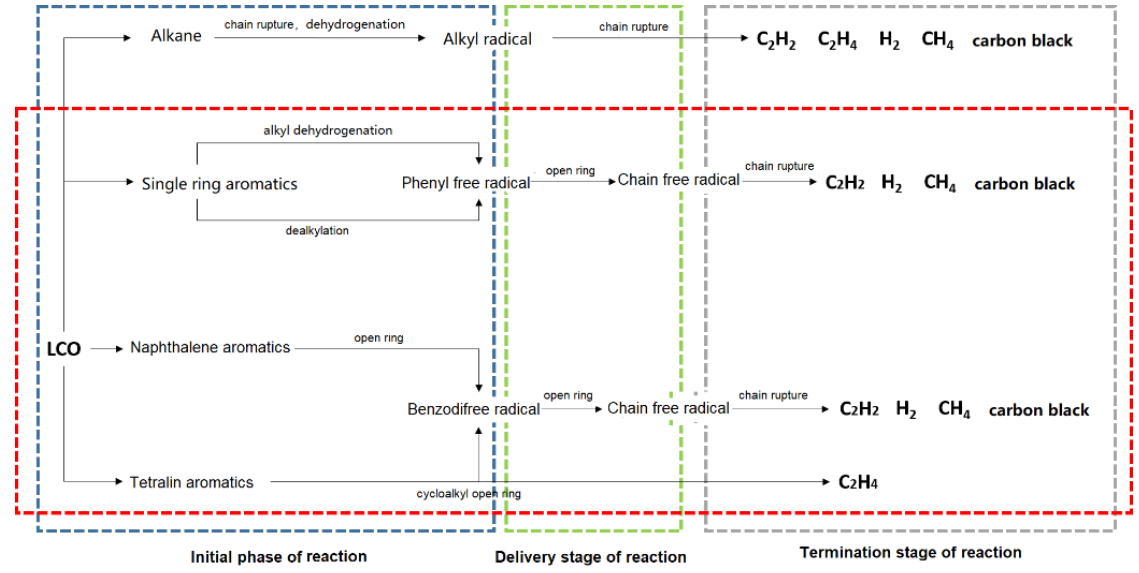
Figure 5. Reactions during LCO high temperature cracking.